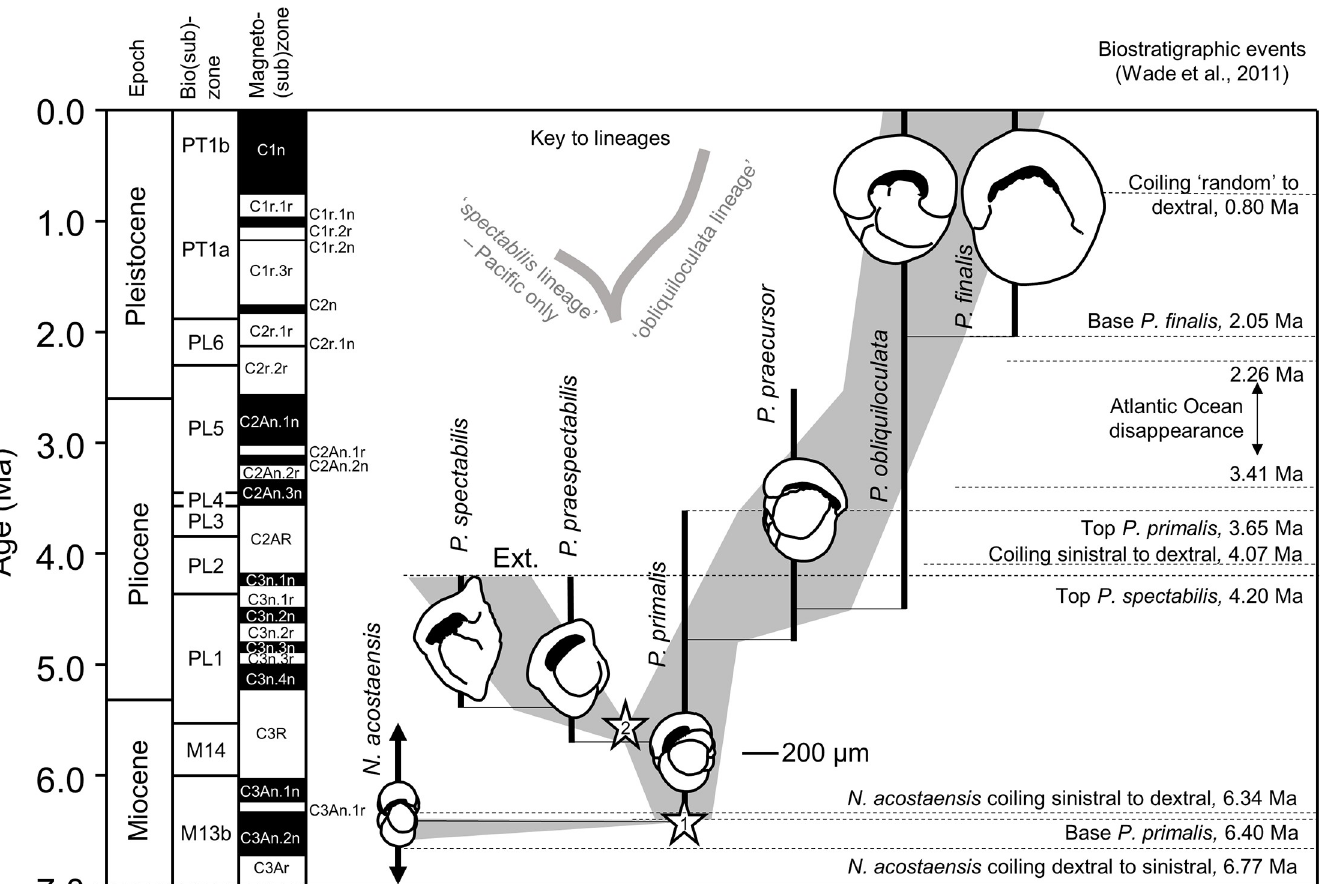
Fig 3. Stratigraphic record of Pulleniatina according to the standard taxonomy, with suggested lineage phylogeny. Vertical bars represent the stratigraphic ranges of named morphospecies. Horizontal lines represent supposed ‘evolutionary’ relationships between morphospecies. Grey shading represents apparent intergradation between morphospecies. Stars represent lineage cladogenetic events: 1, when Pulleniatina primalis diverged from Neogloboquadrina acostaensis and 2, when the spectabilis lineage diverged from the main lineage. ‘Ext.’ represents extinction of the spectabilis lineage. Biostratigraphic zones and events are from the compilation of Ref [39]. Foraminifer sketches show typical specimens in apertural view, to scale.